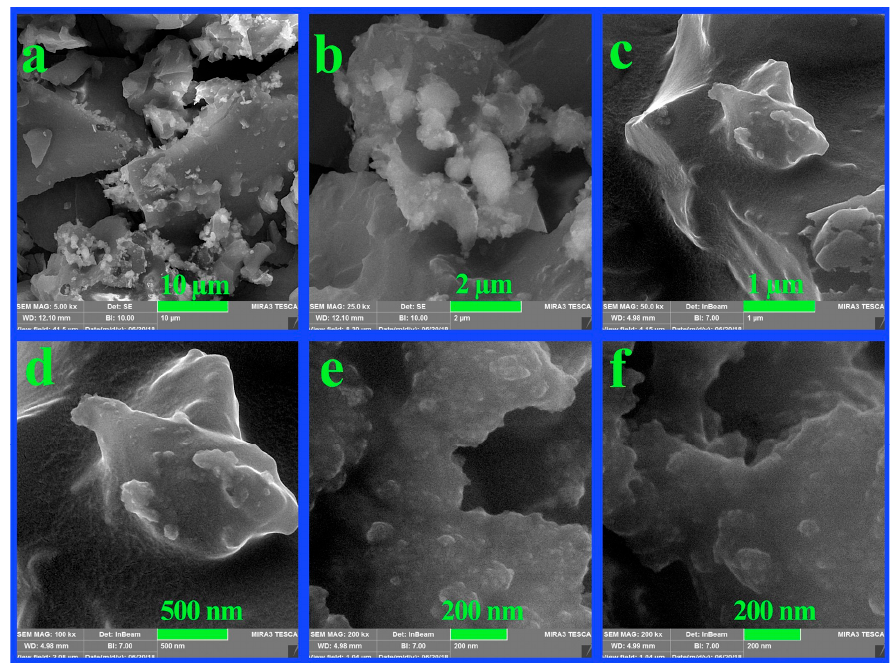
Figure 9. FE-SEM micrographs of NC 2 at different scales.